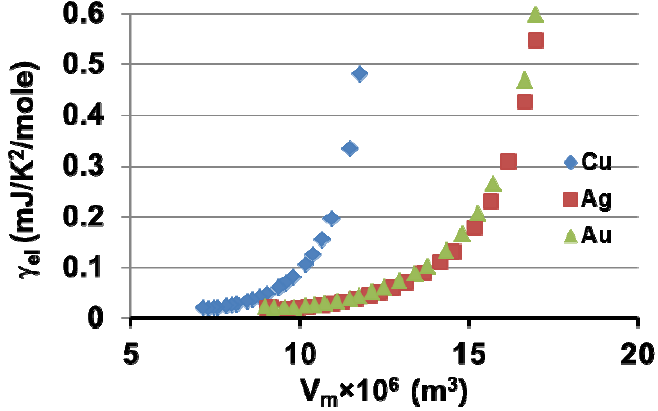
Figure 12. Electronic specific heat coefficient of Cu, Ag, and Au superclusters as a function of supercluster radius R at T = T the critical radius (black